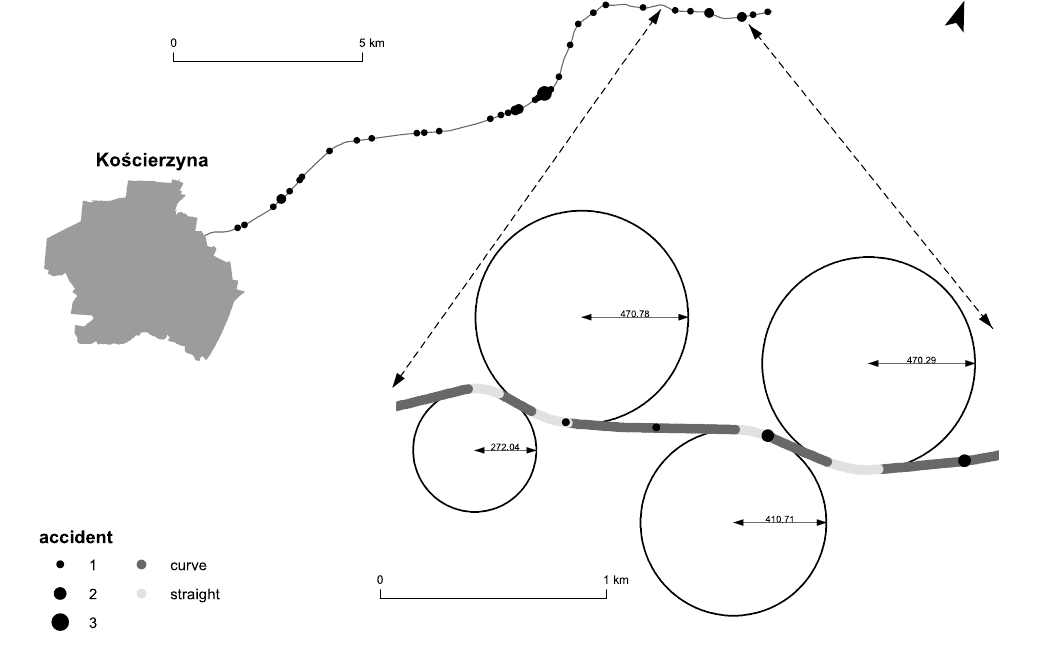
Figure 3. Road curves parameters.